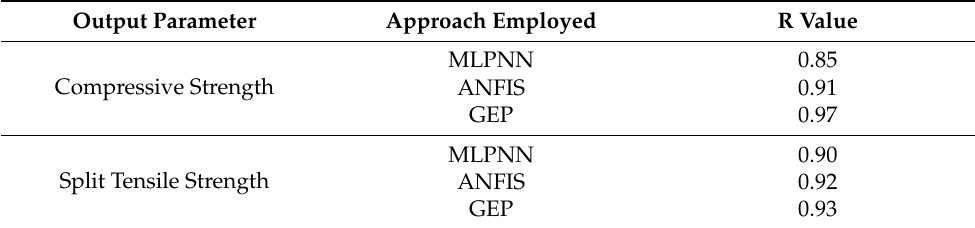
Table 7. R 2 Values of